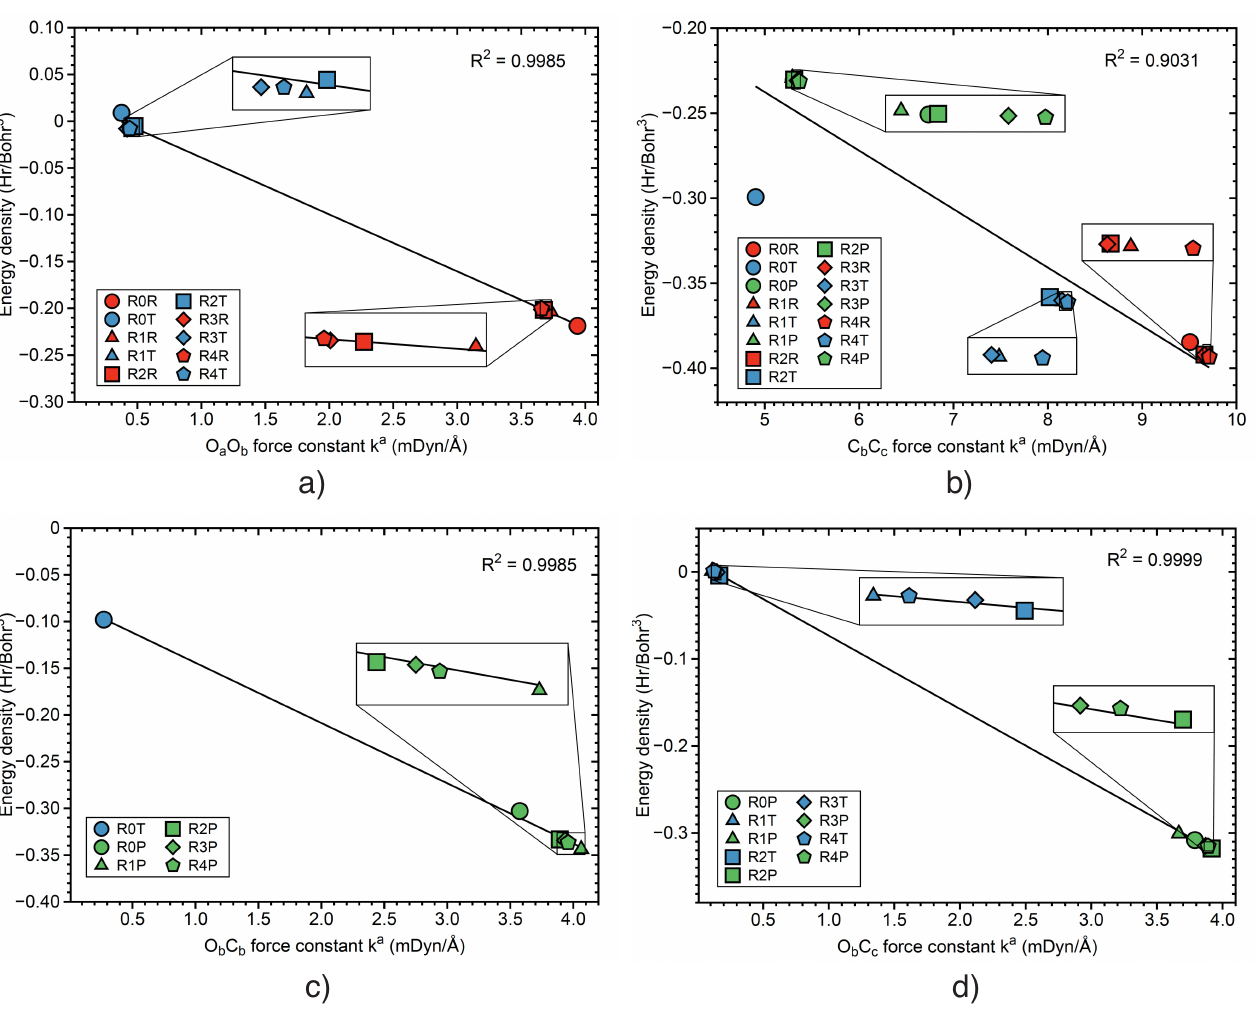
Figure 11. Correlation between energy density and local mode force constant. ( a ) OO bond, ( b ) CC bond, ( c ) O b C b bond and ( d ) O b C c bond. RnR, RnT and RnP indicate the reactant (red color), TS (blue color) and product (green color) for reactions Rn , with n=0, · · · 4. B3LYP/6-31G(d,p)/SDD(Ti) level of